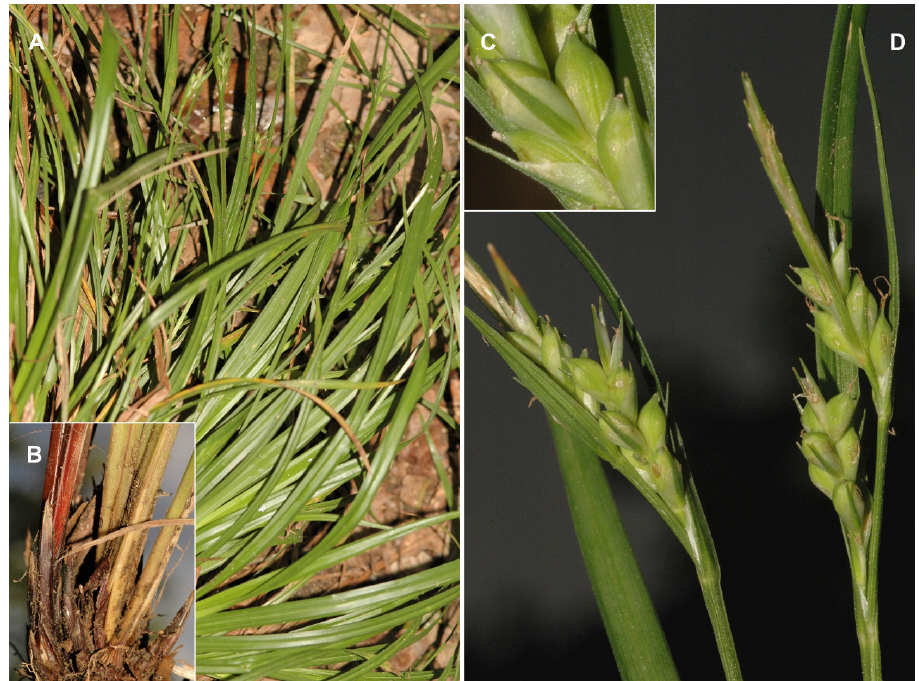
Figure 2. Carex olbiensis . A, General aspect; B, Detail of the red-purple base of the plant; C, Hyaline, long aristate female glumes and utricles showing a short truncate beak; D, Inflorescence.